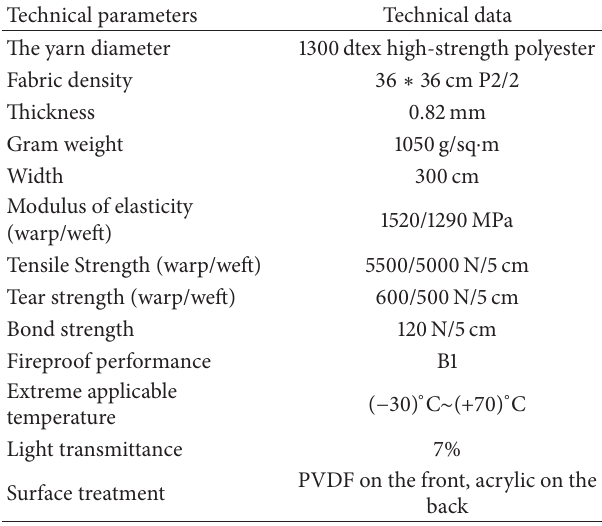
Table 4: The vibration frequency of the C1 point for square